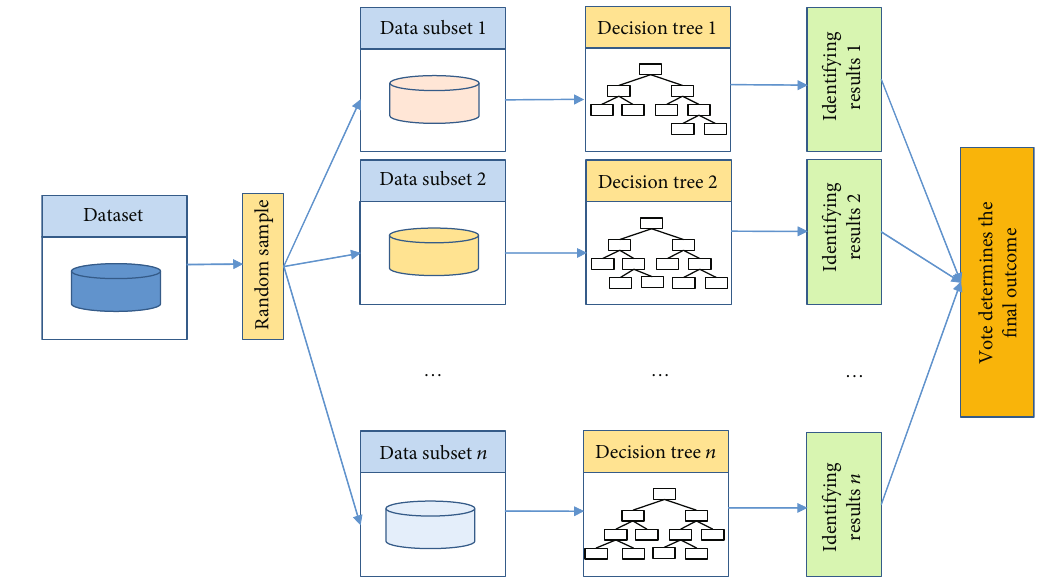
Figure 4: The principle of random forest method. Table 2: The characteristics analysis of the random forest